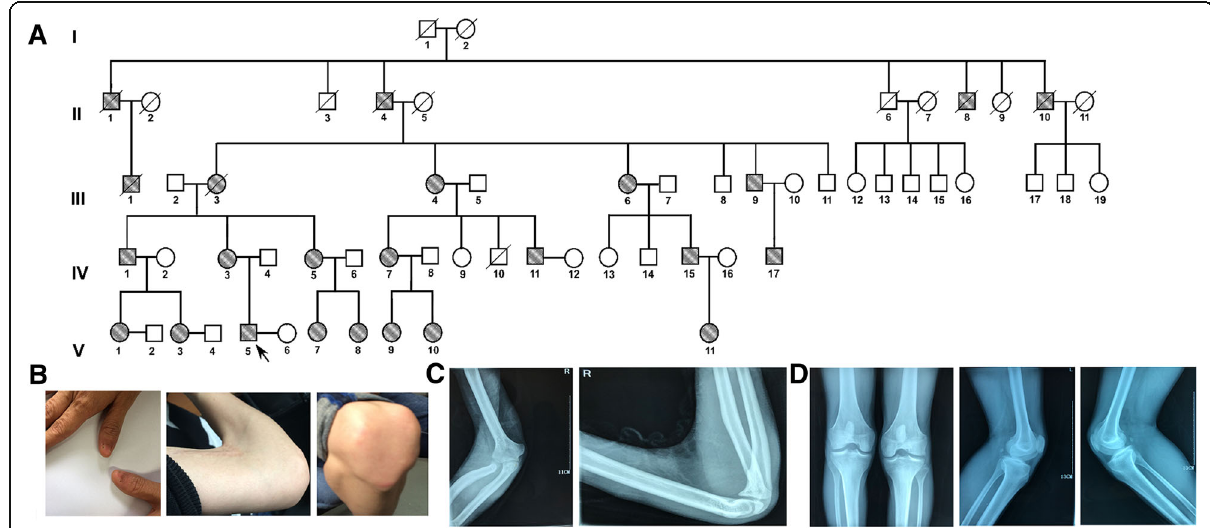
Fig. 1 Pedigree of a Chinese family affected by nail – patella syndrome and the clinical phenotype of the patient V-5. a Pedigree of the Chinese family showing autosomal dominant inheritance of nail – patella syndrome. Dark solid squares (males) and solid circles (females) indicate affected individuals. Deceased individuals are indicated by a slash (/); the arrow shows the proband. b Clinical manifestations of the patient ’ s nails, elbows, and patellae. c Results of radiographic examination of the patient ’ s elbows. d Results of X-ray examination of the patient ’ s knee joint. The findings indicated smaller than usual bilateral